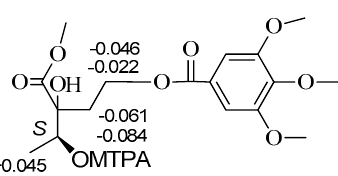
Figure 3. Δδ ( S - R ) values of MTPA ester derivative of 2 .